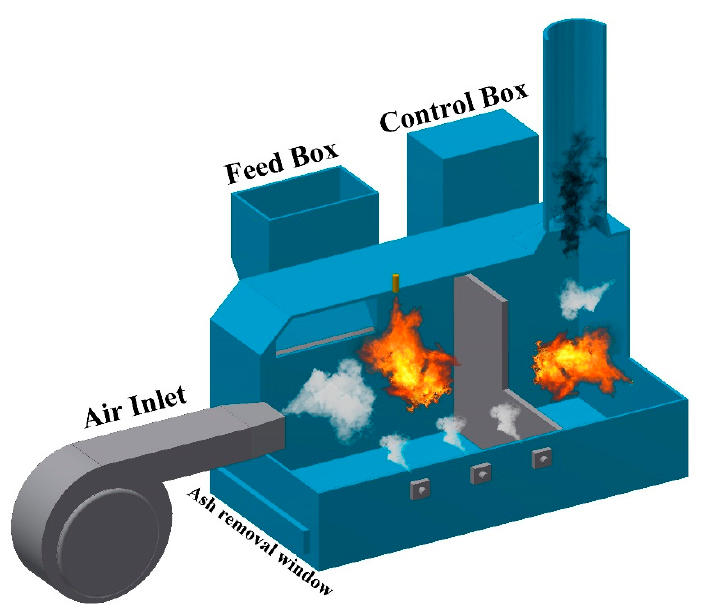
Figure 1. A schematic 3D view of the considered portable incinerator.